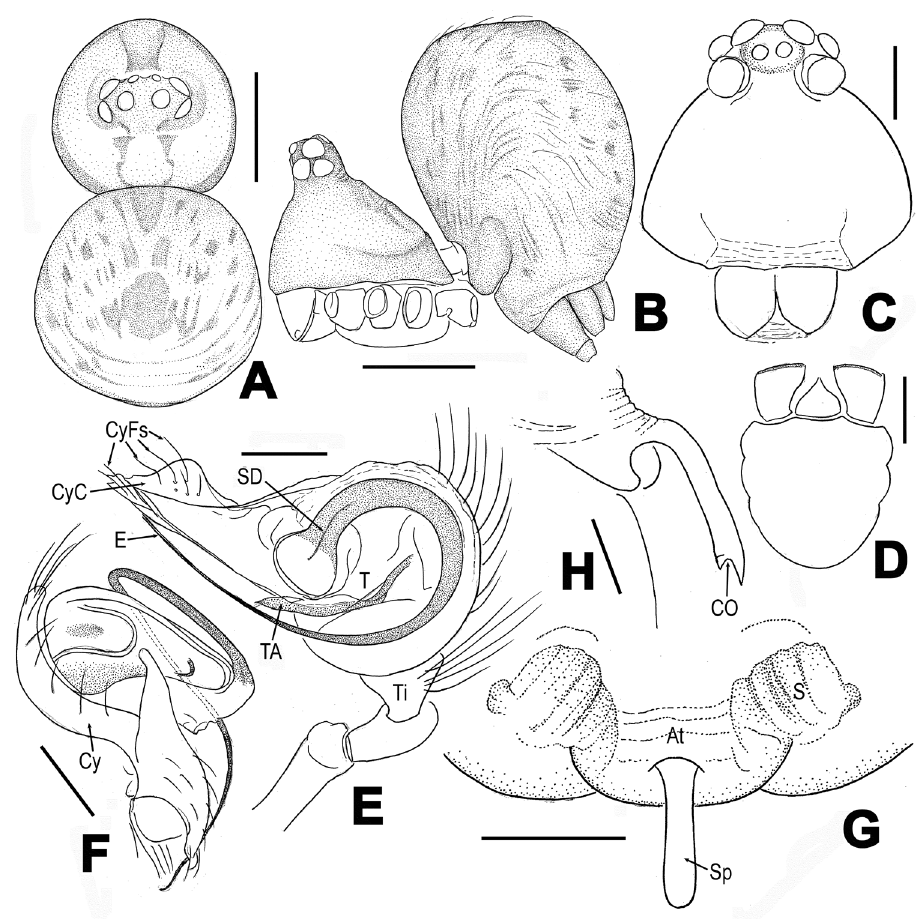
Figure 1. Trogloneta nojimai (Ono, 2010), comb. n., male holotype ( A–F ) and female paratype ( G, H ) (cited from Ono, 2010, slightly modified). A, B habitus (appendages omitted) C Prosoma D Endites, labium and sternum E, F Left palp G, H Epigyne A, F dorsal B, H lateral C anterior D, G ventral E ret- rolateral. Abbreviations: At atrium; CO copulatory opening; Cy cymbium; CyC cymbial conductor; CyFs setae on cymbial fold; E embolus; S spermathecae, SD spermatic duct; Sp scape; T tegulum, TA tegular apophysis; Ti tibia. Scale bars: 0.25 mm ( A, B ) ; 0.10 mm ( C–H )